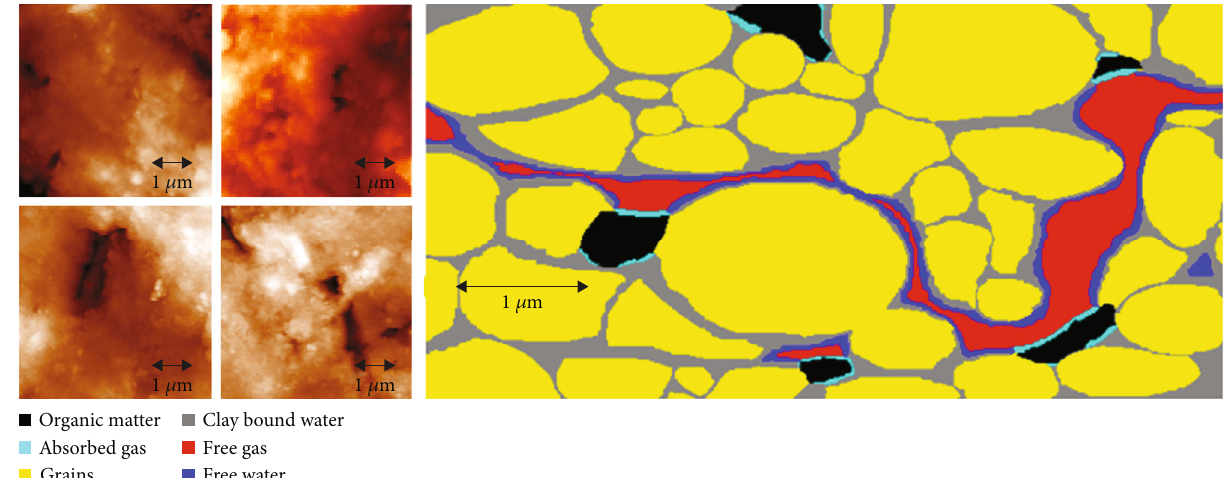
Figure 2: AFM images and 2D schematic of pore and throat structure of gas-bearing shale [25].